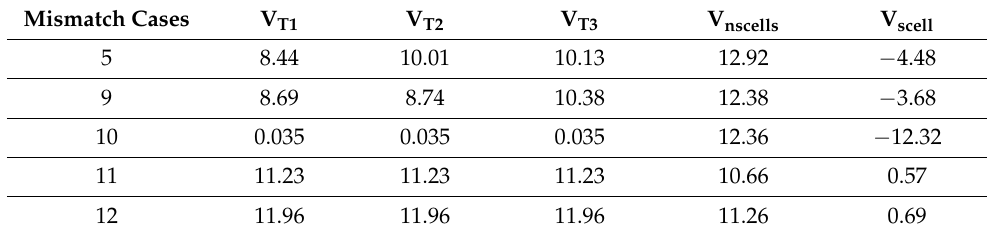
Table 5. Voltage across shaded PV sub-modules and PV cell(s) equipped with DPP